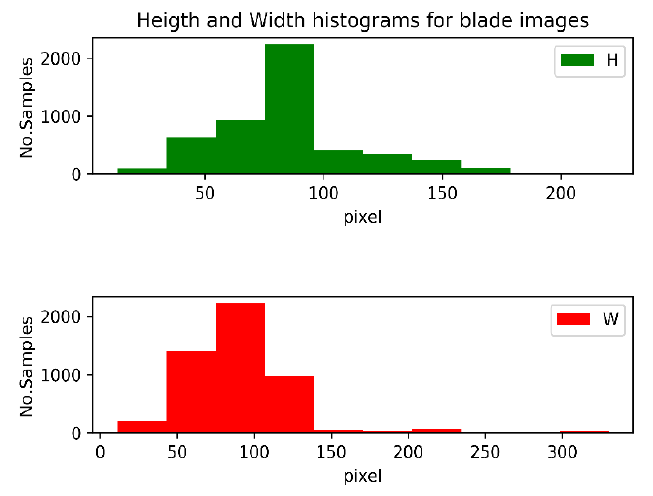
Figure 6. Distribution of height and width for 5000 blade sub-images in our